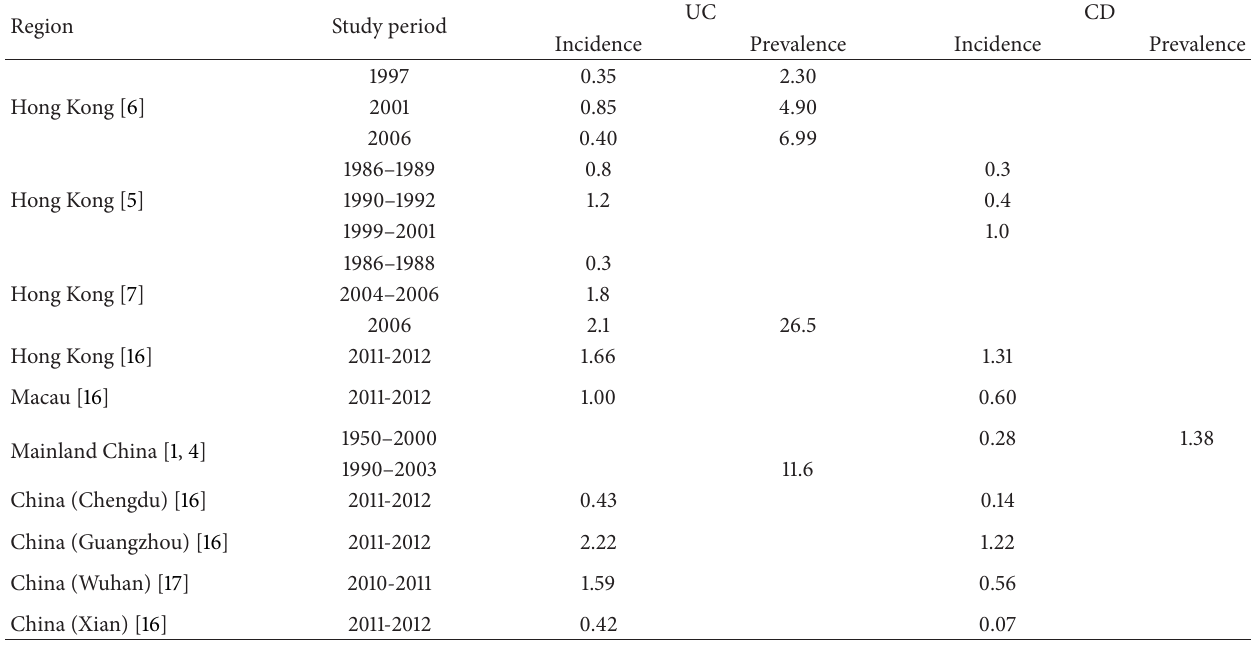
Table 1: Incidence and prevalence (per 100,000) of IBD in China.